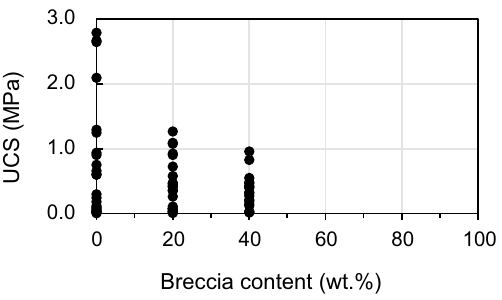
Figure 11. Effect of breccia content on the unconfined compressive strength (UCS) of artificial fault core. The range of UCS depends on the breccia content.